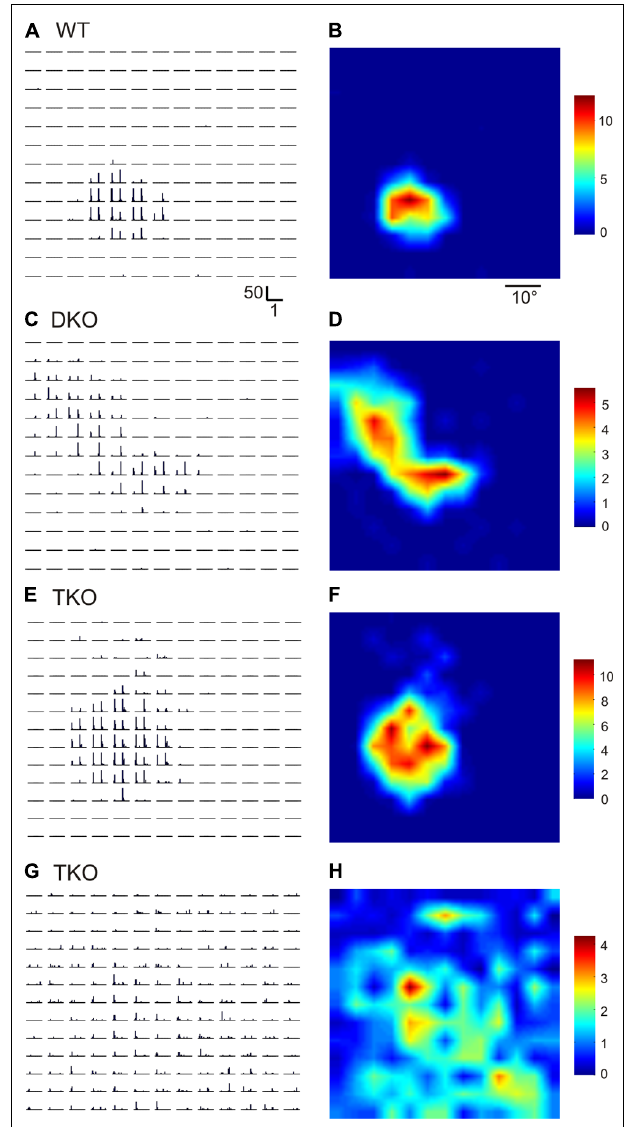
FIGURE 1 | Disrupted receptive field structures in the SC of ephrin-A knockout mice. (A,B) Receptive field of a SC neuron inWT mouse. A shows peri-stimulus timing histograms (PSTH) in response to spots flashed at different locations on a 13 × 13 grid in visual space. Scale bars are 50 spikes/s (y-axis, for firing rate in each 50 ms bin) and 1 s (x-axis). Both On and Off responses were evoked within the receptive field, as indicated by the two peaks in individual PSTHs.The receptive field structure determined by the PSTHs is shown in B in a color scale (right, in spikes/s, for mean firing rate in the 1 s stimulus duration). (C–H) Example receptive fields of SC neurons in ephrin-A double (DKO) and triple KO (TKO)